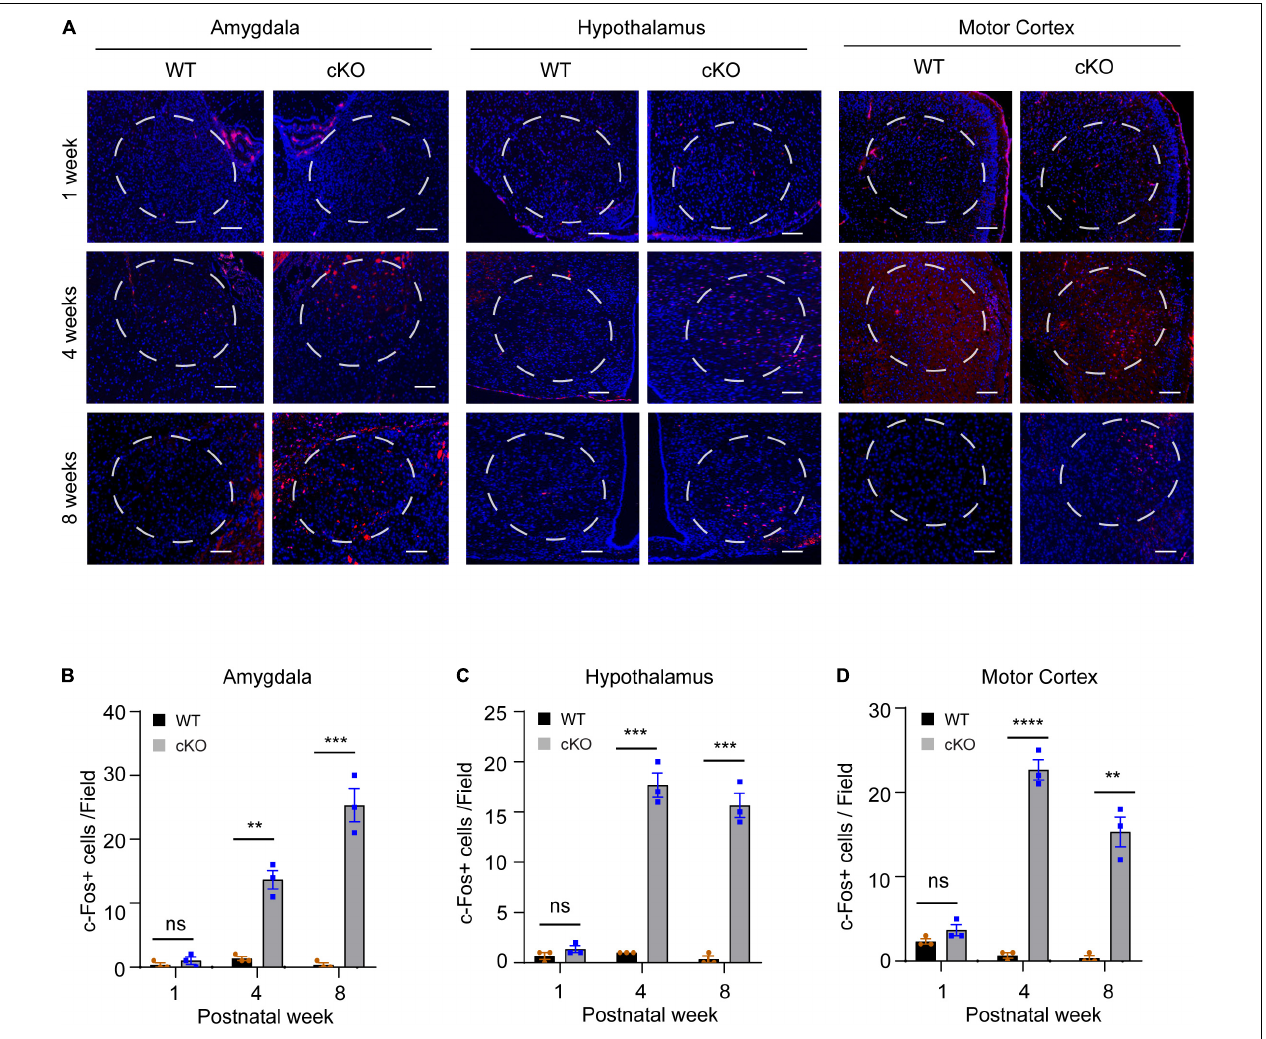
FIGURE 5 | Loss of Ash1l in the mouse brain causes neuronal hyperactivity in broad brain regions. (A) Representative photos showing the c-Fos positive cells in amygdalae hypothalami, and motor cortices. bar = 100 µ m. (B–D) Bar plots showing the c-Fos positive cells in amygdalae (B) , hypothalami (C) , and motor cortices (D) . n = 3 brain samples/per genotype. The numbers of c-Fos positive cells per brain were calculated as the mean c-Fos positive cell numbers from three sections ( ∼ 100 µ m apart) examined. A frame ( ∼ 0.25 mm 2 ) was used to gate the courting area for all sections. P- value calculated using two-tailed t- tests. Error bars in graphs represent mean ± SEM. ** p < 0.01, *** p < 0.001, **** p <